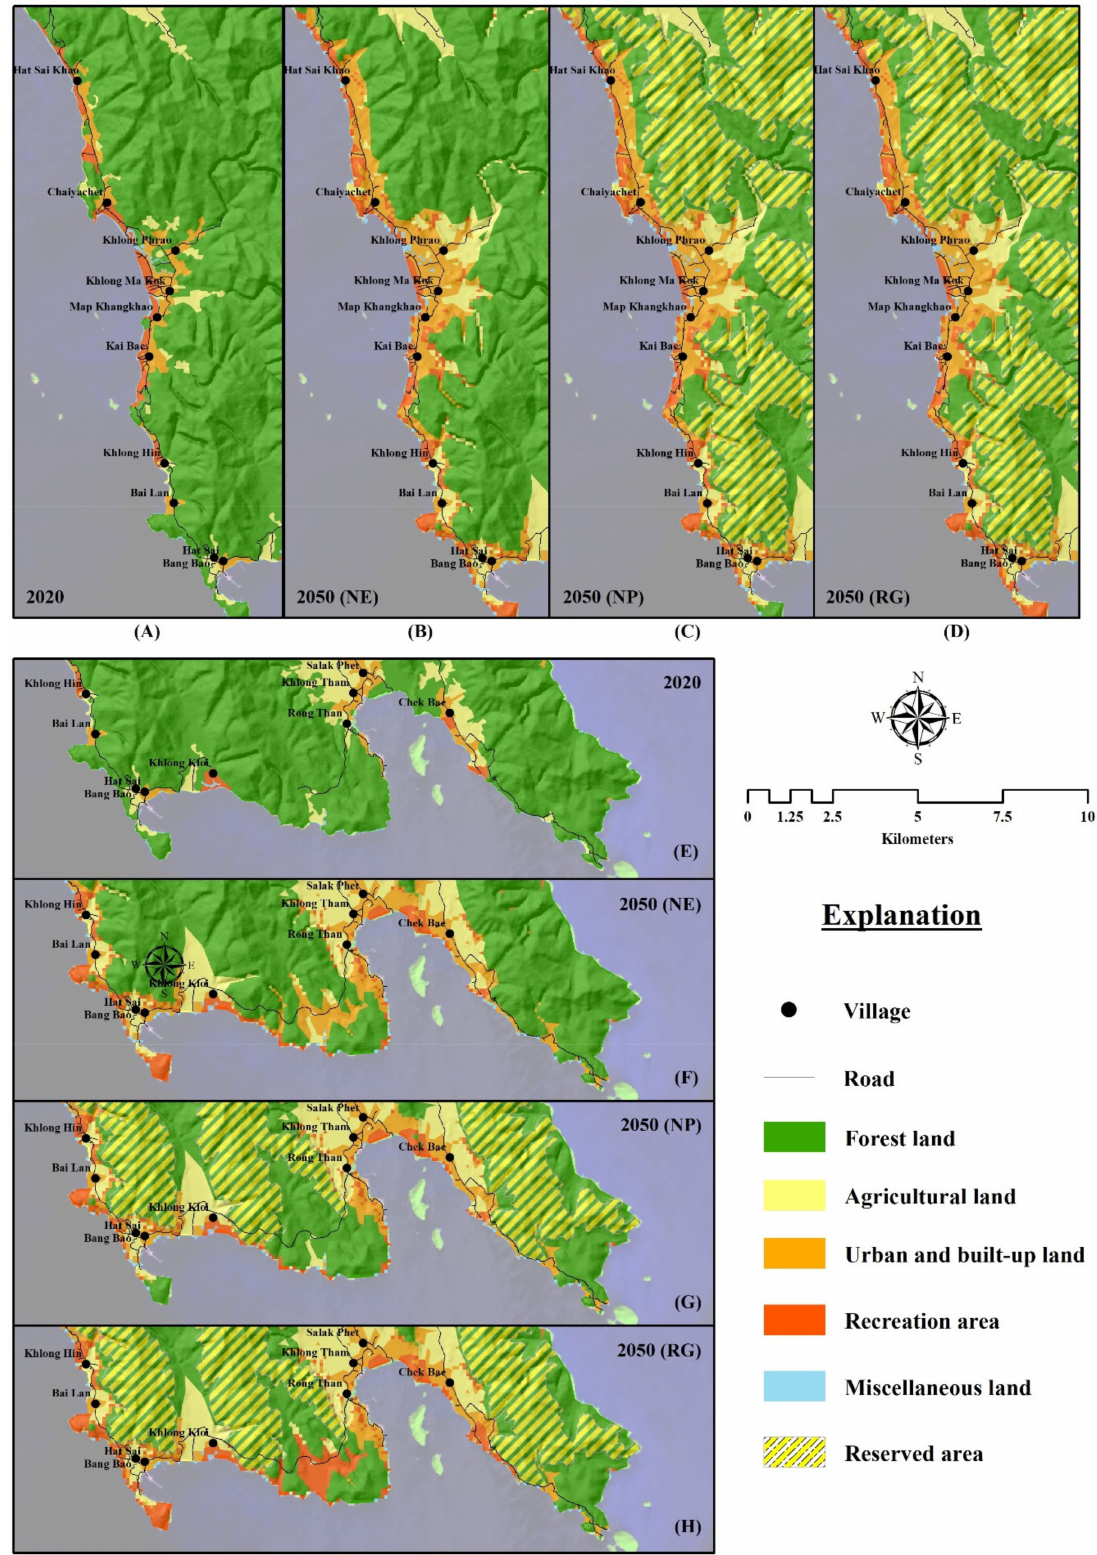
Figure 7. Land-use simulation maps showing Koh Chang Island areas susceptible to LUC in 2050 for the western coastal area ( A ) under NE ( B ); NP ( C ); and RG ( D ) scenarios, and for the southern coastal area ( E ) under NE ( F ); NP ( G ); and RG ( H )